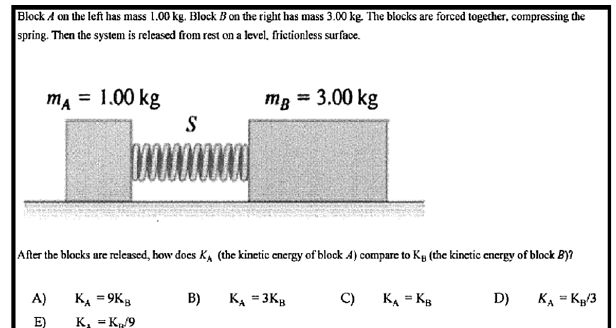
TABLE III. The ANOVA analysis of students ’ difference scores with conceptual items only on the final exams at each institution shows no significant effect for enrolling in the lab.